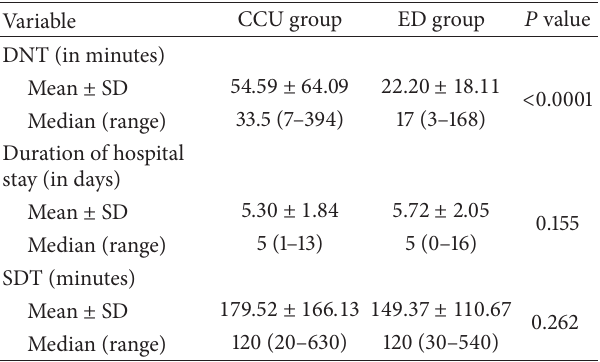
Table2:Door-to-needletime,symptom-to-doortime,andduration of hospital